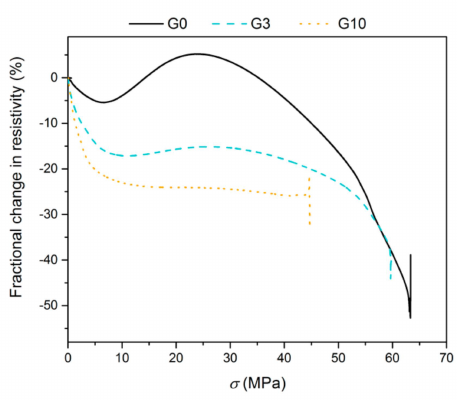
Figure 13. Fractional change in resistivity vs. compressive stress of composites G0, G3 and G10 measured at 1 kHz until the complete destruction of the